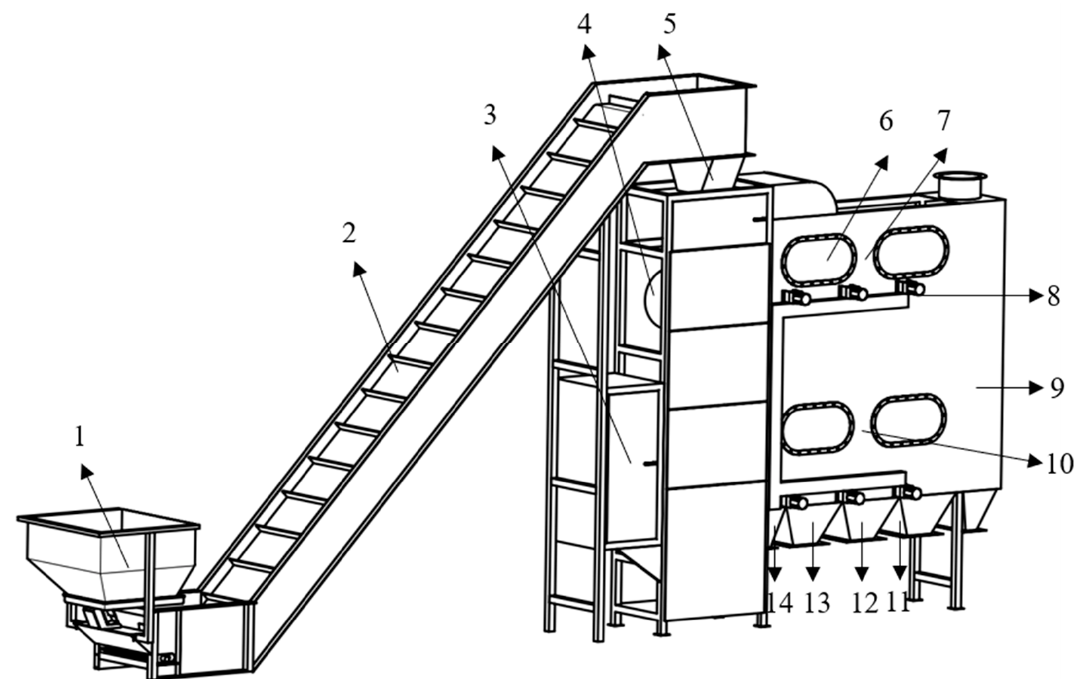
Figure 1. Schematic diagram of double-layer tea winnowing machine. 1, No.1 vibratory feeder; 2, Z-shaped conveyor belt; 3, Electric control cabinet; 4, Upper fan; 5, No.2 vibratory feeder; 6, Viewing Window; 7, Upper wind separation chamber; 8, Baffle motor; 9, Dust chamber; 10, Lower wind separation chamber; 11, No. 4 lower-level material outlet; 12, No. 3 lower-level material outlet; 13, No. 2 lower-level material outlet; 14, No. 1 lower-level material outlet.